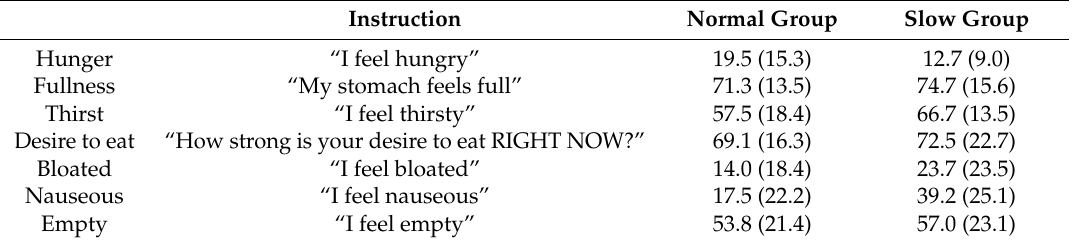
Table A1. Baseline appetite ratings (mean; SD). Table B1. Baseline appetite ratings (mean; SD).